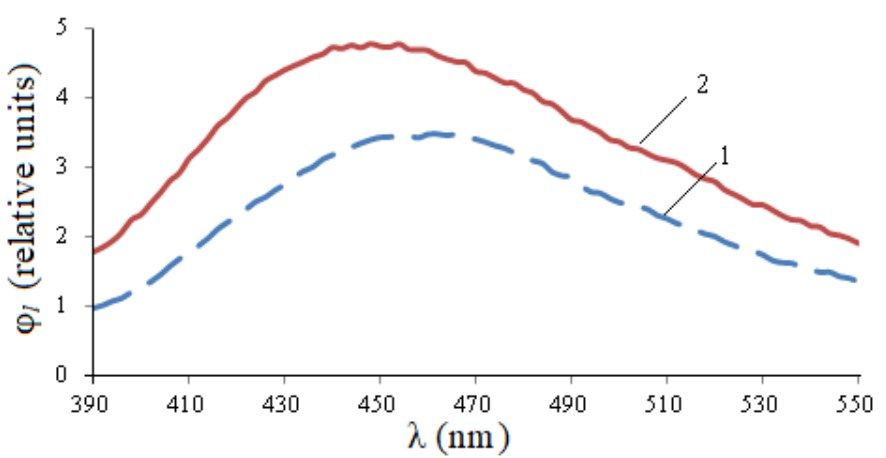
Figure 4. Spectral characteristics of luminescence of wheat seeds at λ e , 2 = 362 nm: 1—not infected, 2—98% infected.